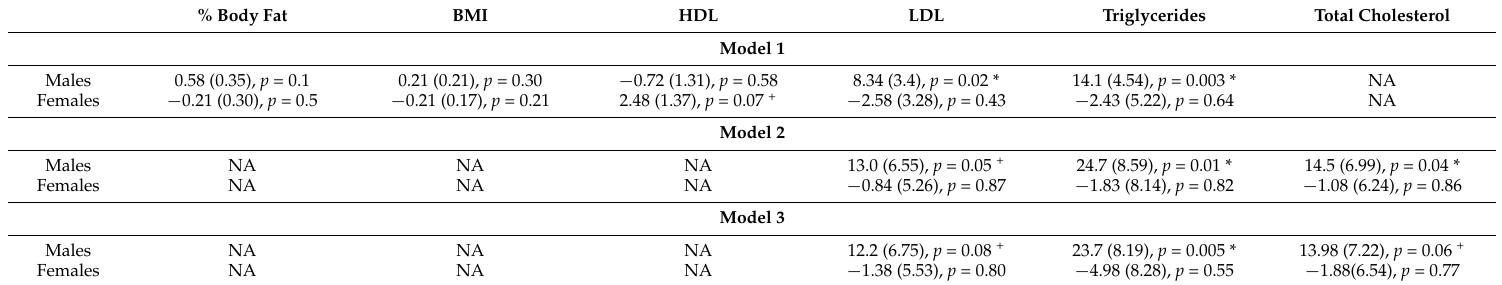
Table 5. Western dietary pattern regression models stratified by sex ( β (standard error), p